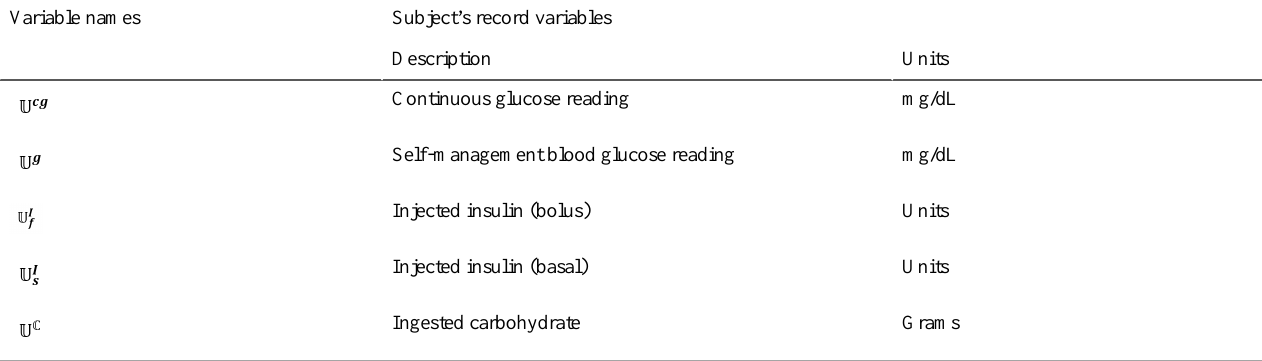
Table 3. Self-collected user